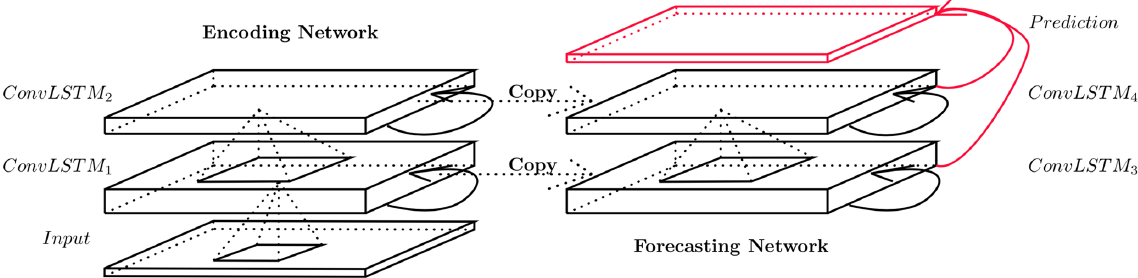
Figure 3. The multi-layered encoding–forecasting ConvLSTM network. The hidden states and cell outputs of the encoding network are copied to the forecasting network, from which the final prediction is made. © Shi et al. (2015). Used with permission.